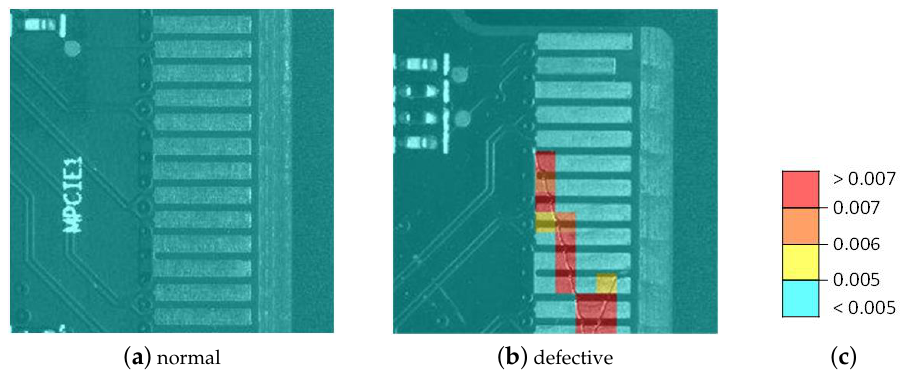
Figure 11. The proposed visualization scheme for the inspection results: ( a ) visualization results for a normal sample; ( b ) visualization for a defective sample; ( c ) colors and their corresponding L2 distances.